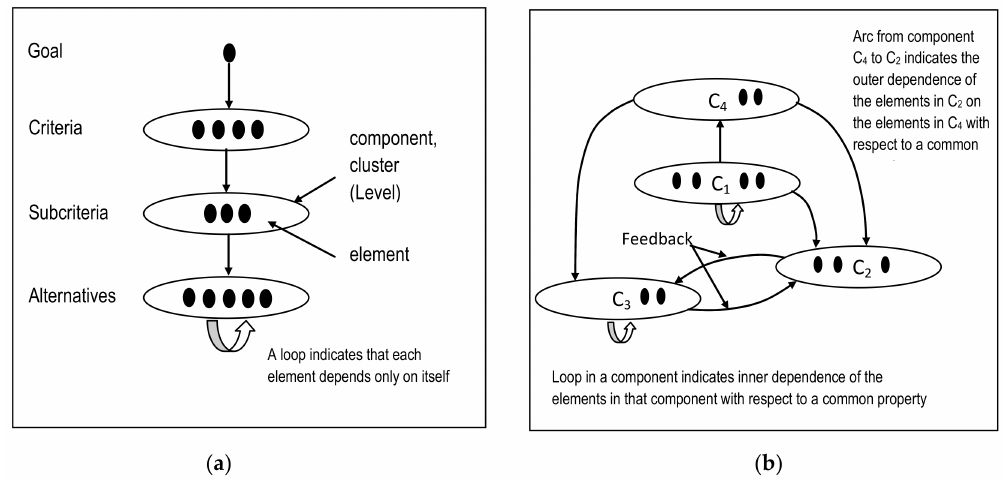
Figure 1. Decision structures in AHP and ANP: ( a ) Linear Hierarchy; ( b ) Feedback